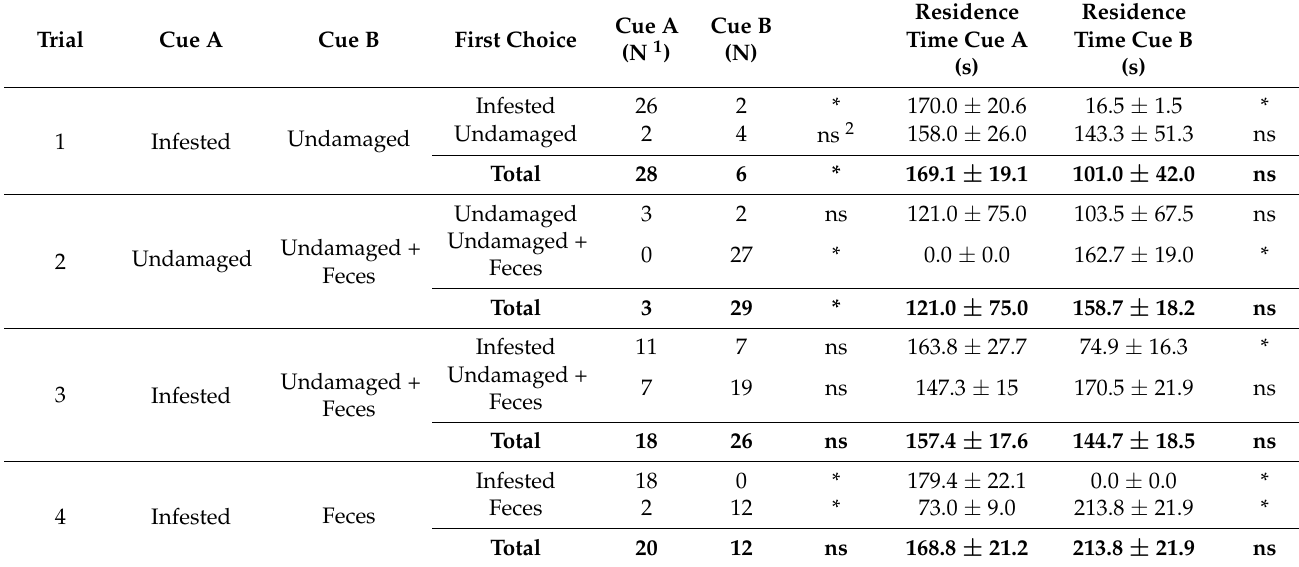
Figure 1. First choice of T. elegans females in choice experiments between paired substrates: I = R. dominica -Infested wheat; U = Undamaged wheat; U+F = Undamaged wheat + R. dominica larval feces; F = R. dominica larval feces. Asterisks indicate statistical differences (χ 2 test, p < 0.05); n.s. = not significant. NS = no-searching female parassitoids. Table 2. Residence times (Mean ± SE) of T. elegans females in choice trials with paired cues. Asterisks (*) indicate significant differences between the number of insects spending Table 2 test; p < 0.05) or between the residence times spent on the cues (Mann–Whitney U test; p < 0.05) within the same